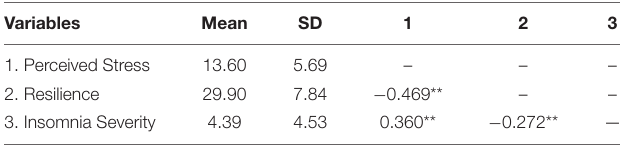
TABLE 2 | Correlations among study variables ( N = 2115).